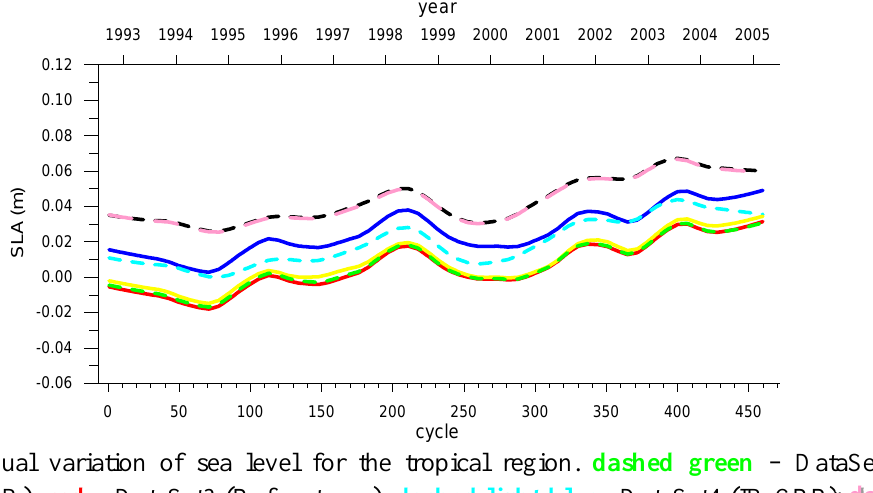
Figure 10a. Interannual variation of sea level for the tropical region. dashed green – DataSet1; blue – DataSet2 (Labroue SSB); red – DataSet3 (Ruf wet_cor); dashed light blue –DataSet4 (IB-CRP);;; dddaaassshhheeeddd pppiiinnnkkk – DataSet5 (IB-VRP); dashed black – DataSet6 (IB-MOG2D); y yy e ee l ll l ll o oo w ww – DataSet7 (CNES orbit).